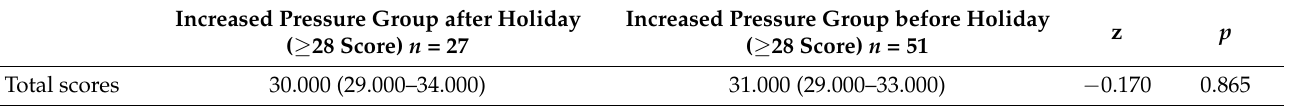
Table 5. Statistical analysis of the increased pressure group before and after the holiday.